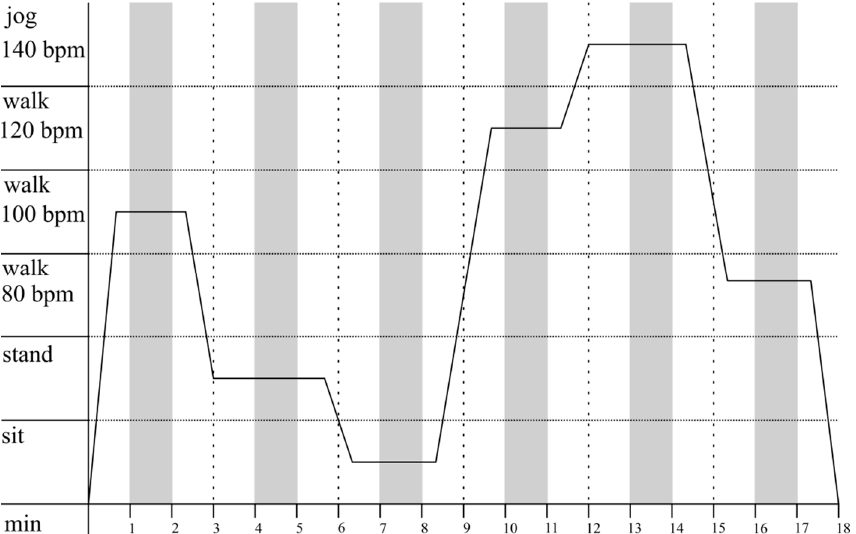
Figure 2. Laboratory part 1: Example protocol of activity distribution as a function of time. Every activity is randomly allocated to one of the six periods of 3 min. While white areas are the time slots in which participants performed transitions; gray areas depict the windows of analysis.